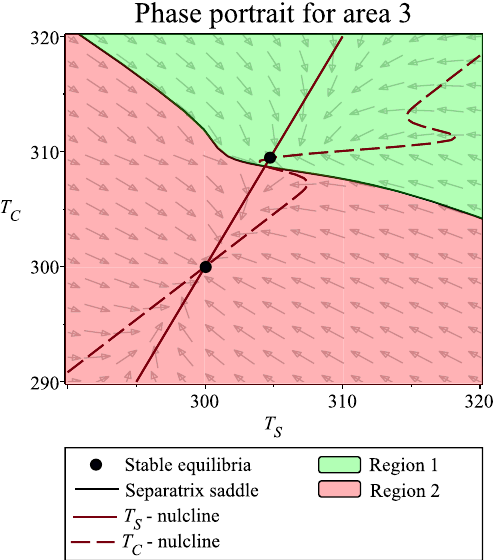
Figure 2. Phase portrait for area 3 for parameter values given by Tables 2 and